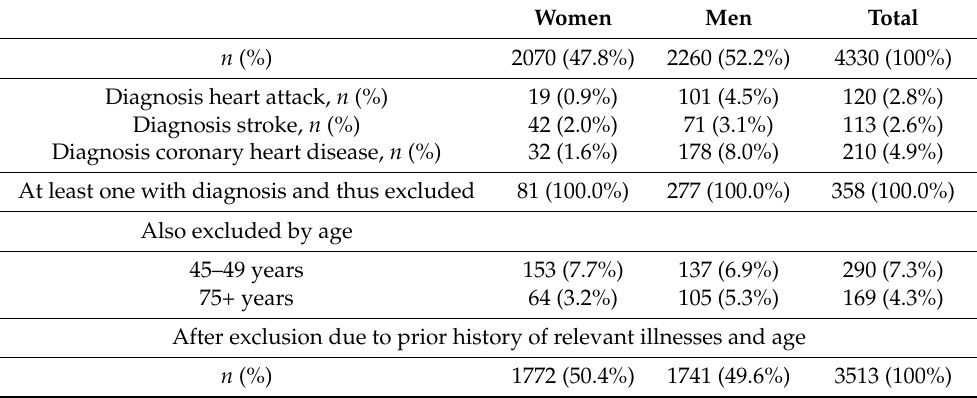
Table 2. Baseline characteristics of the study